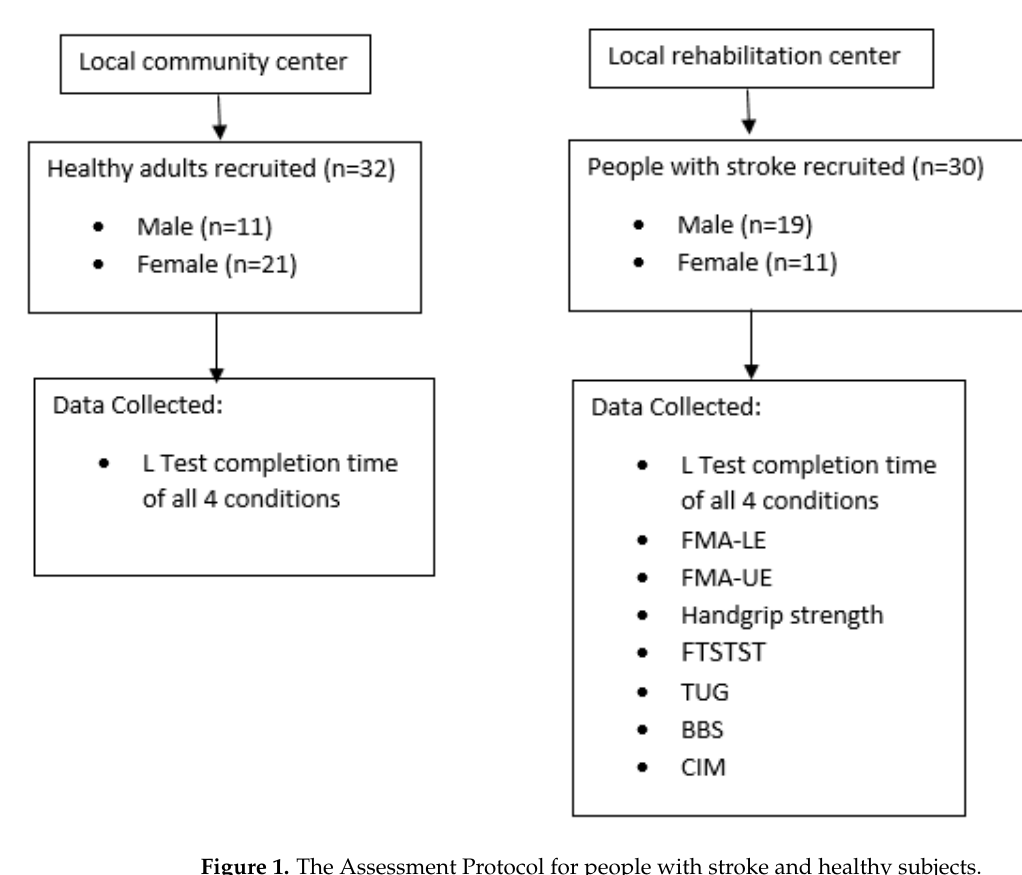
Figure 1. The Assessment Protocol for people with stroke and healthy subjects.